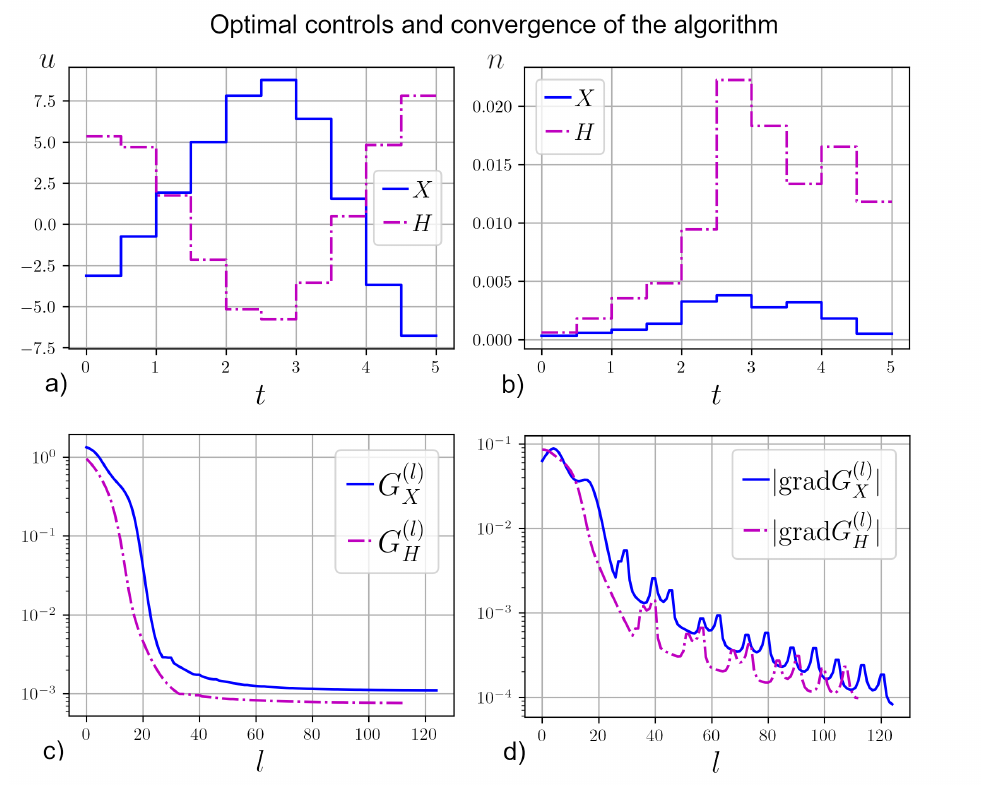
Figure 2. Optimized coherent control u ( t ) (subplot a ) and incoherent control n ( t ) (subplot b ) which generate the quantum gate X (blue line) and the Hadamard quantum gate H (purple line); convergence ( l ) of the fidelity—the objective functional G , U ∈ { X , H } (33)—(subplot c ); norm of the gradient of the U objective functional (subplot d ) vs. number l of the optimization algorithm (31) iterations.